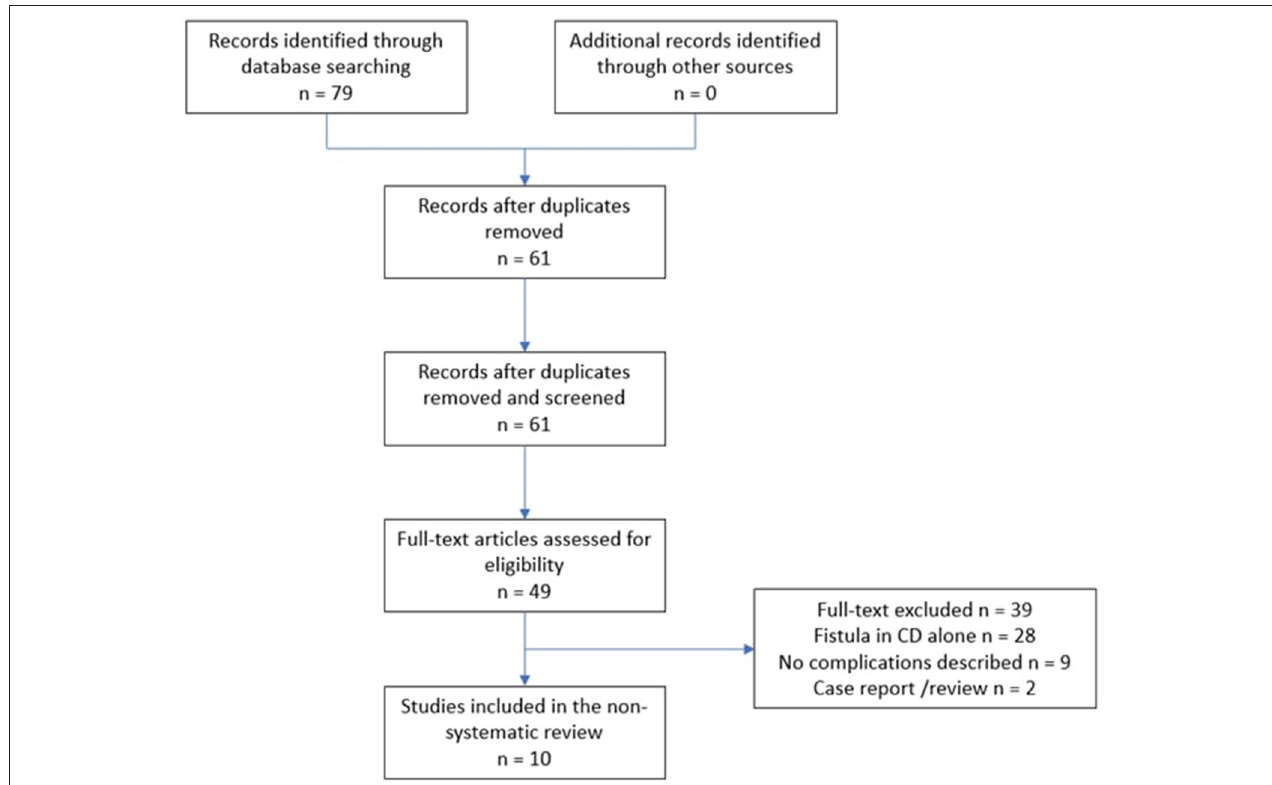
FIGURE 1 | Flow chart of article selection